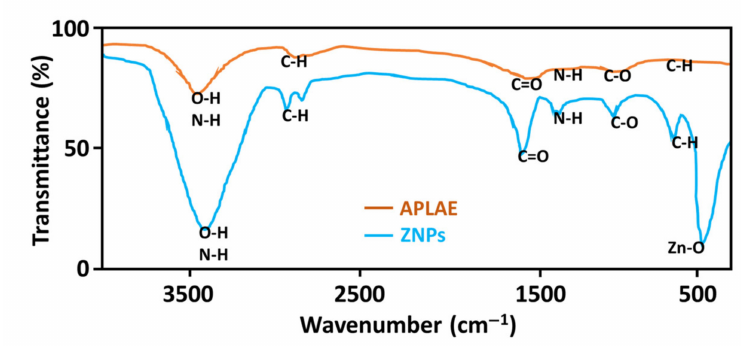
Figure 2. FTIR spectrum of pure APLAE and biosynthesized ZnPs.